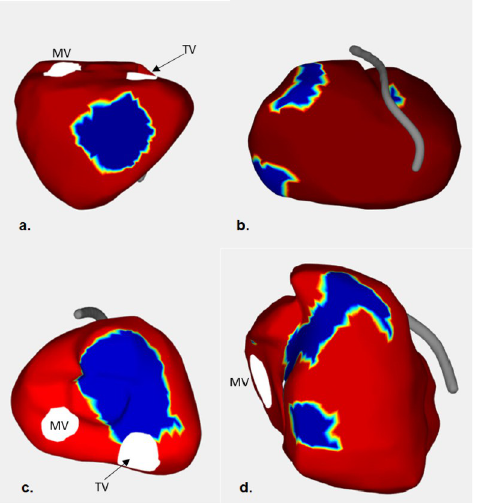
Fig 2. Examples of terminal ventricular activation in four ARVC patients. The figure presents the area activated during the last 20 msec of the total ventricular epicardial activation (noted with blue colour) in four ARVC patients. Note that the terminal ventricular activation varied among ARVC patients and occurred in the RV inferior wall (a); in three different areas of the RV (paraseptal, RV base and RV free wall)(b); isolated in RVOT (c);and in two separate areas in RVOT and RV base (d). ARVC = Arrhythmogenic Right Ventricular Cardiomyopathy, RVOT = right ventricular outflow tract, RV = right ventricle, LV = left ventricle, TV: tricuspidalis valve, MV: mitralis valve, LAD = left anterior descending coronary